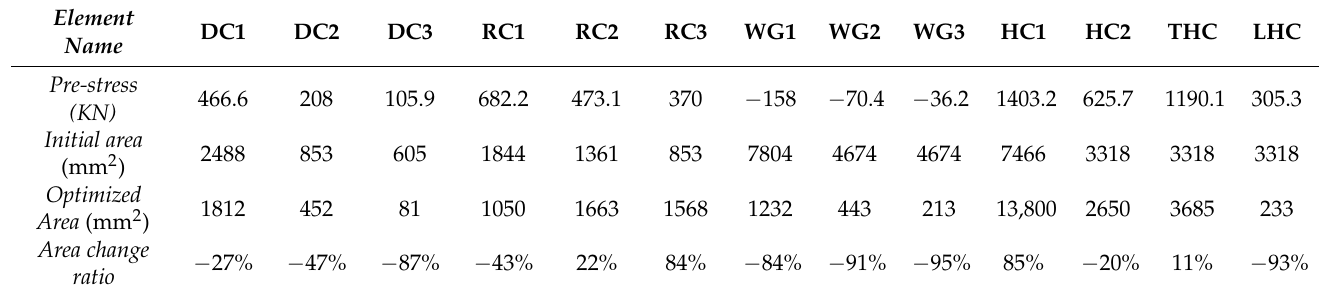
Table 1. Initial pre-stress and section parameters of structural